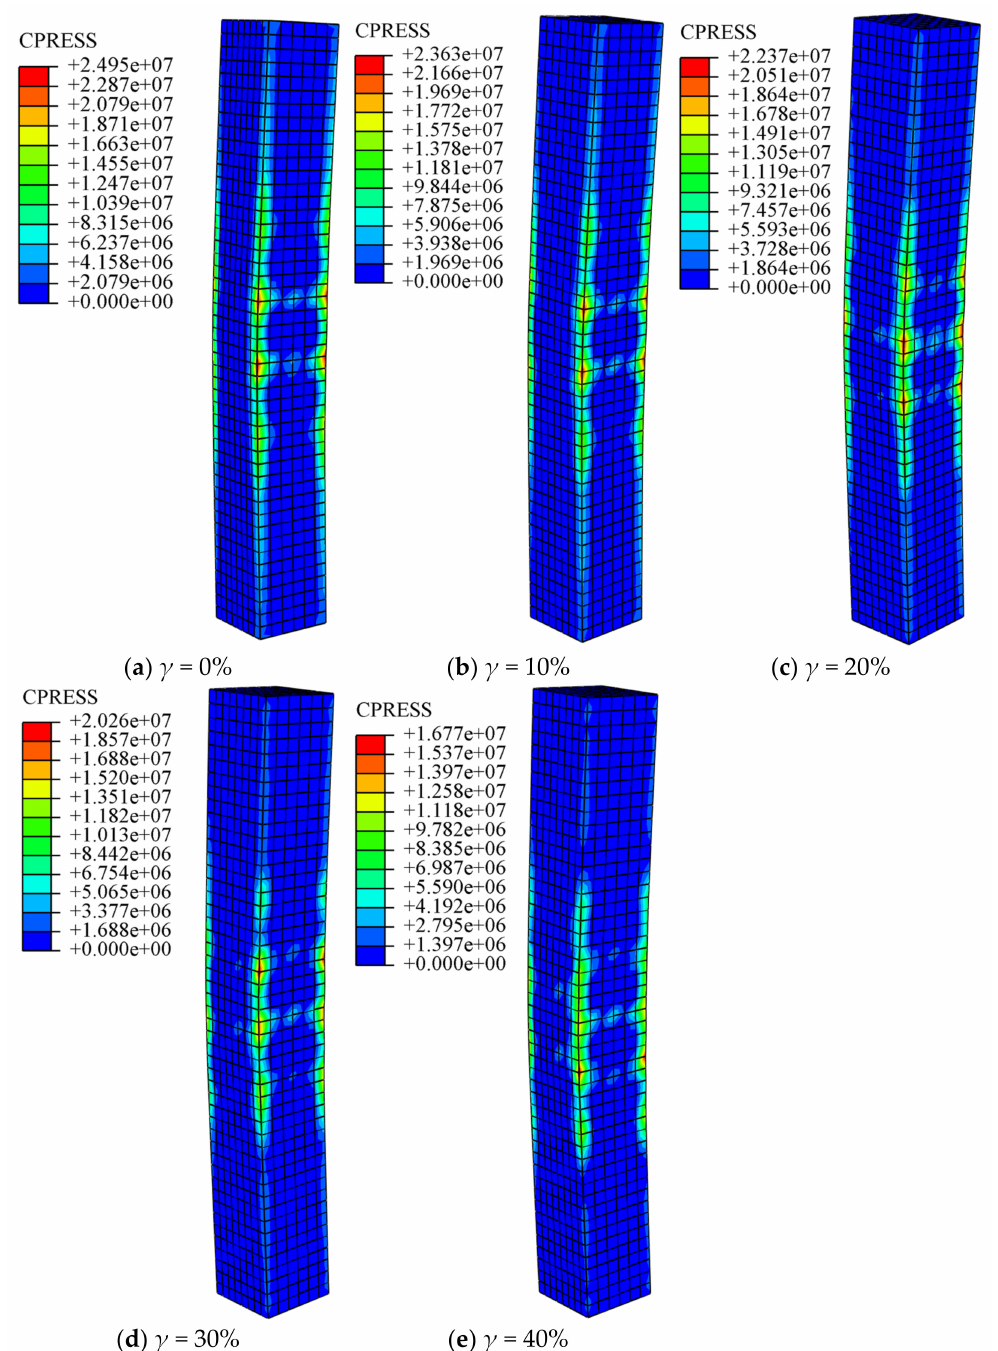
Figure 6. Steel tube-concrete normal contact force distribution at peak load point (unit: N). ( a ) γ = 0%; ( b ) γ = 10%; ( c ) γ = 20%; ( d ) γ = 30%; ( e ) γ =